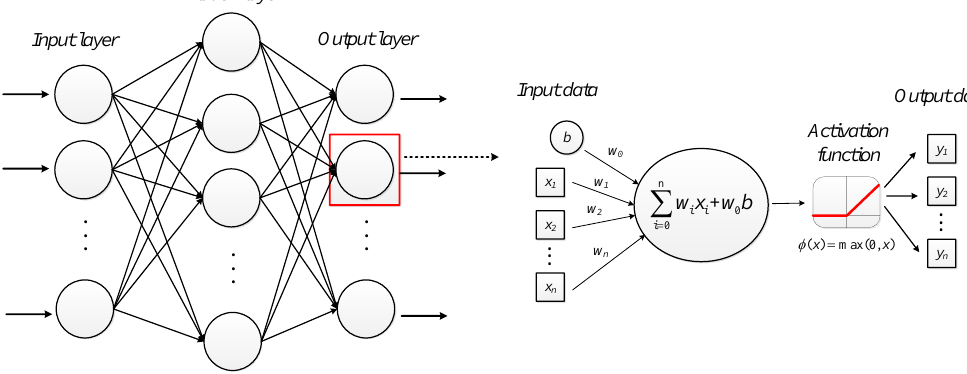
Figure 6. Structure and the principle of ANN, its details of neurons including activation function.